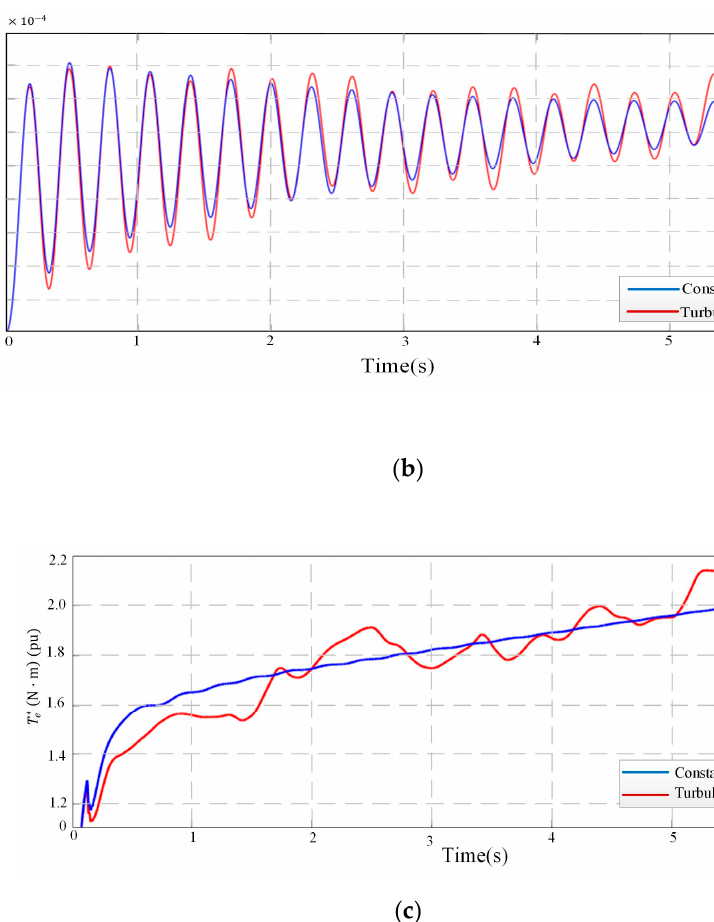
Figure 11. Simulation Results under constant wind speed and turbulent wind. ( a ) Output mechanical torque on the shaft ( T shaft ); ( b ) Torsion vibration angle ( θ s ); ( c ) The electromagnetic torque reference value T e* .